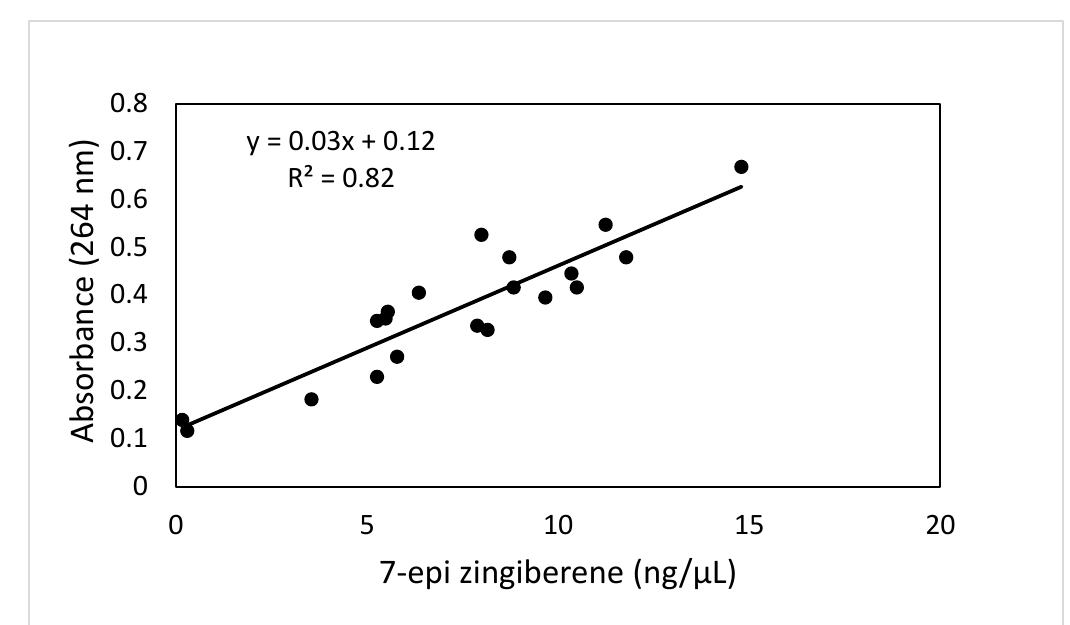
Figure 10. Relationship between absorbance at 264 nm and 7-epi zingiberene content (ng/µL) determined by GC-FID of leaflet washes obtained from BC5F1 genotypes.